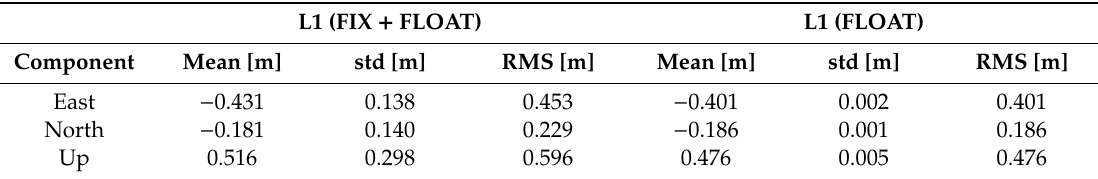
Table 4. Comparison between FIX + FLOAT solutions with the FLOAT-only ones, if the L1 frequency is considered.